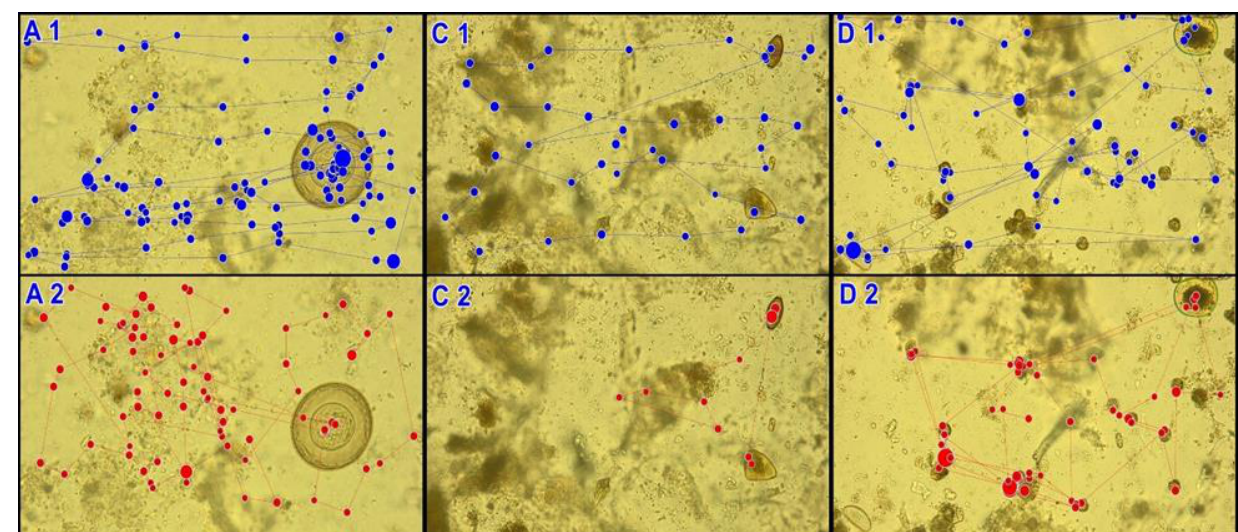
Figure 3. Example scanning paths based on the analysis of preparation A , Hymenolepis diminuta , C, Trichuris trichiura , and D, Enterobius vermicularis (1, correct diagnosis, 2, incorrect diagnosis. Dot-fixation (eye hold); dot diameter is directly proportional to the time the eye is held. Line-saccade (quick shift of eyesight from one point to another).